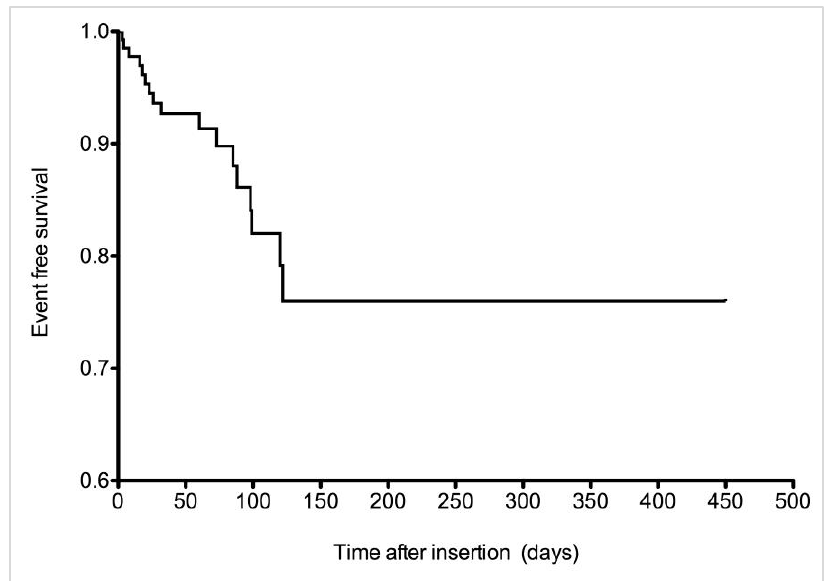
Figure 2: Kaplan-Meier curve of catheter survival based on the occurrence of complications that led to catheter